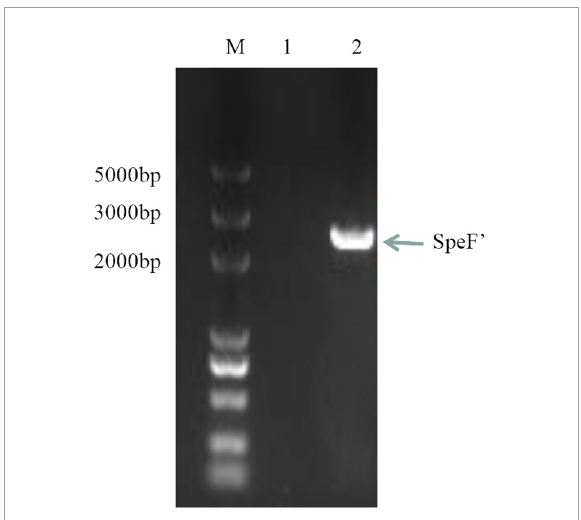
FIGURE1 SpeF amplicon obtained from the polymerase chain reaction. Lane M: DNA Marker (5,000 bp). Lane 1: negative control (no DNA template added). Lane 2: SpeF amplicon gene from the wild strain of Shewanella xiamenensis